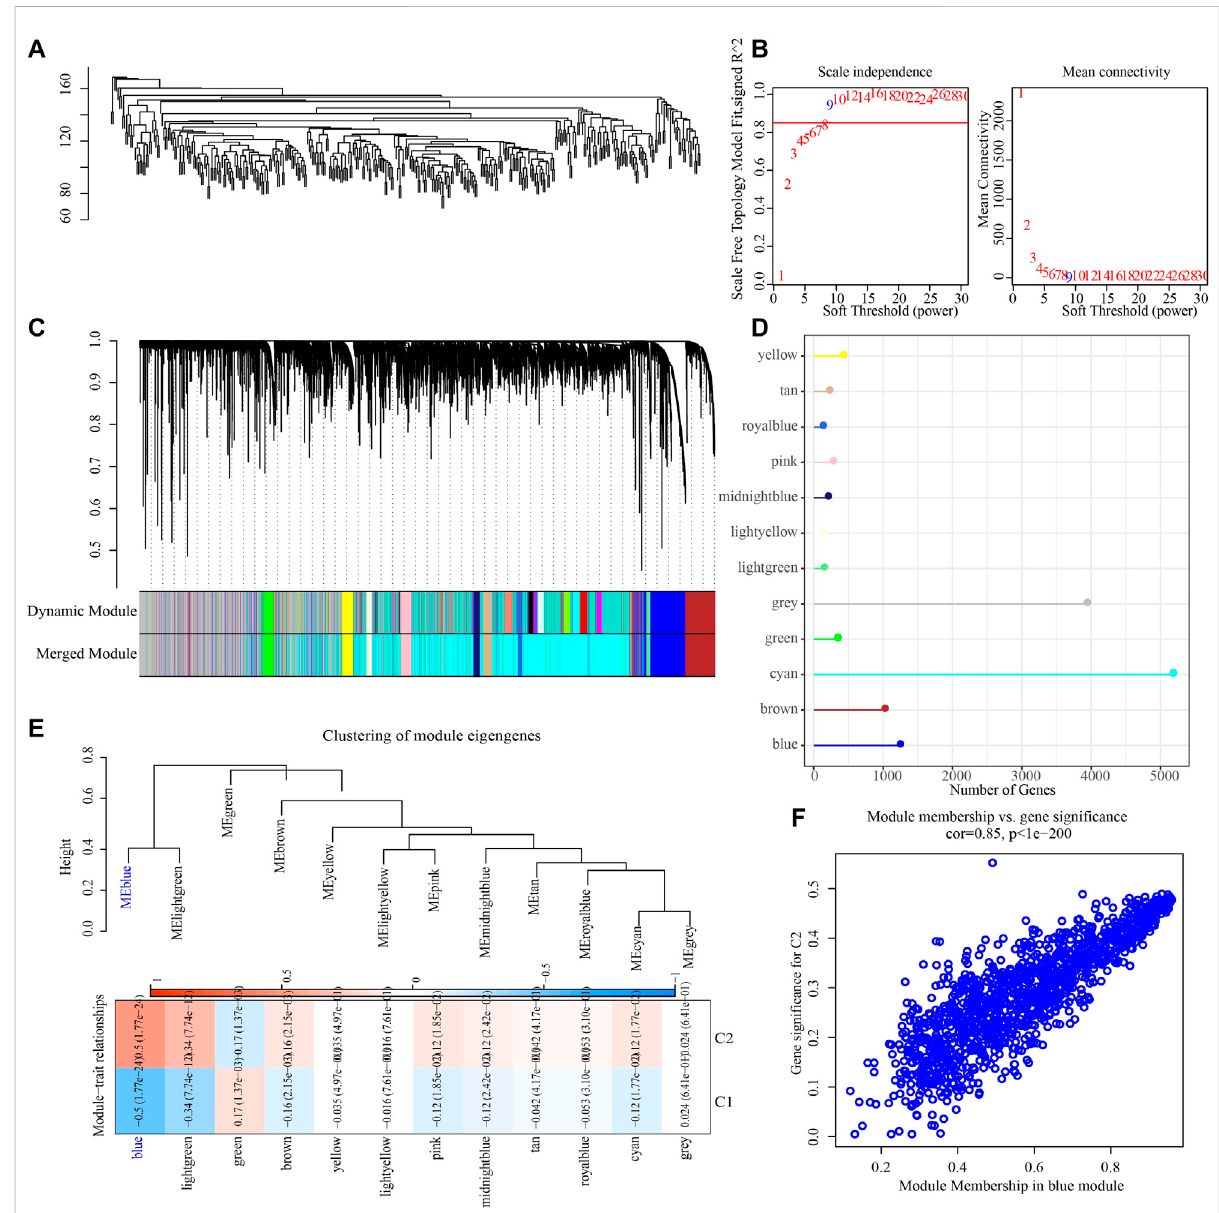
FIGURE 3 Identi fi cation of gene modules related to necroptosis subtypes. (A) The clustering tree of 373 OV samples in the TCGA dataset. (B) Analysis of scale-free exponent and average connectivity of various soft threshold powers. (C) Cluster dendrogram of the co-expression network modules. (D) The number of genes in each module. (E) The heatmap of the relationship between module eigengenes and necroptosis subtypes. (F) The association strength between gene signi fi cance (GS) and module membership (MM) for the C2 in the blue